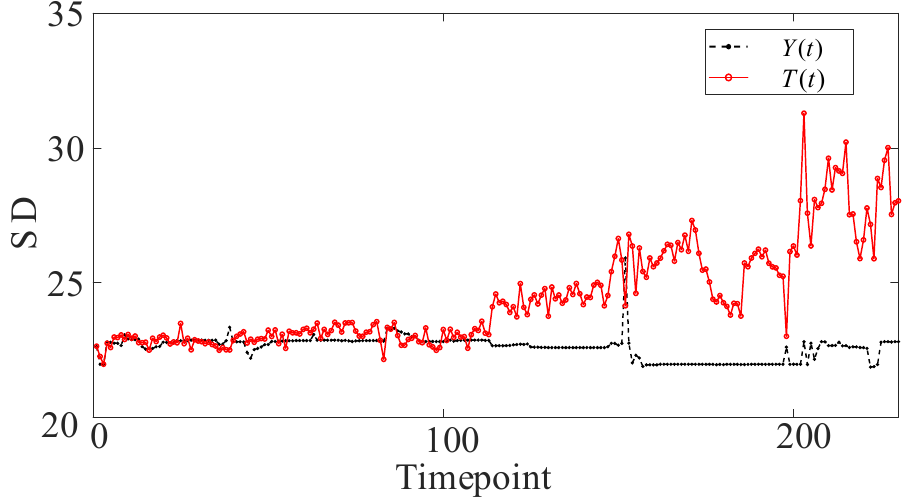
( ) R t . Figure 8. Unit time-domain degradation index sequence R 1 ( t ) . 1